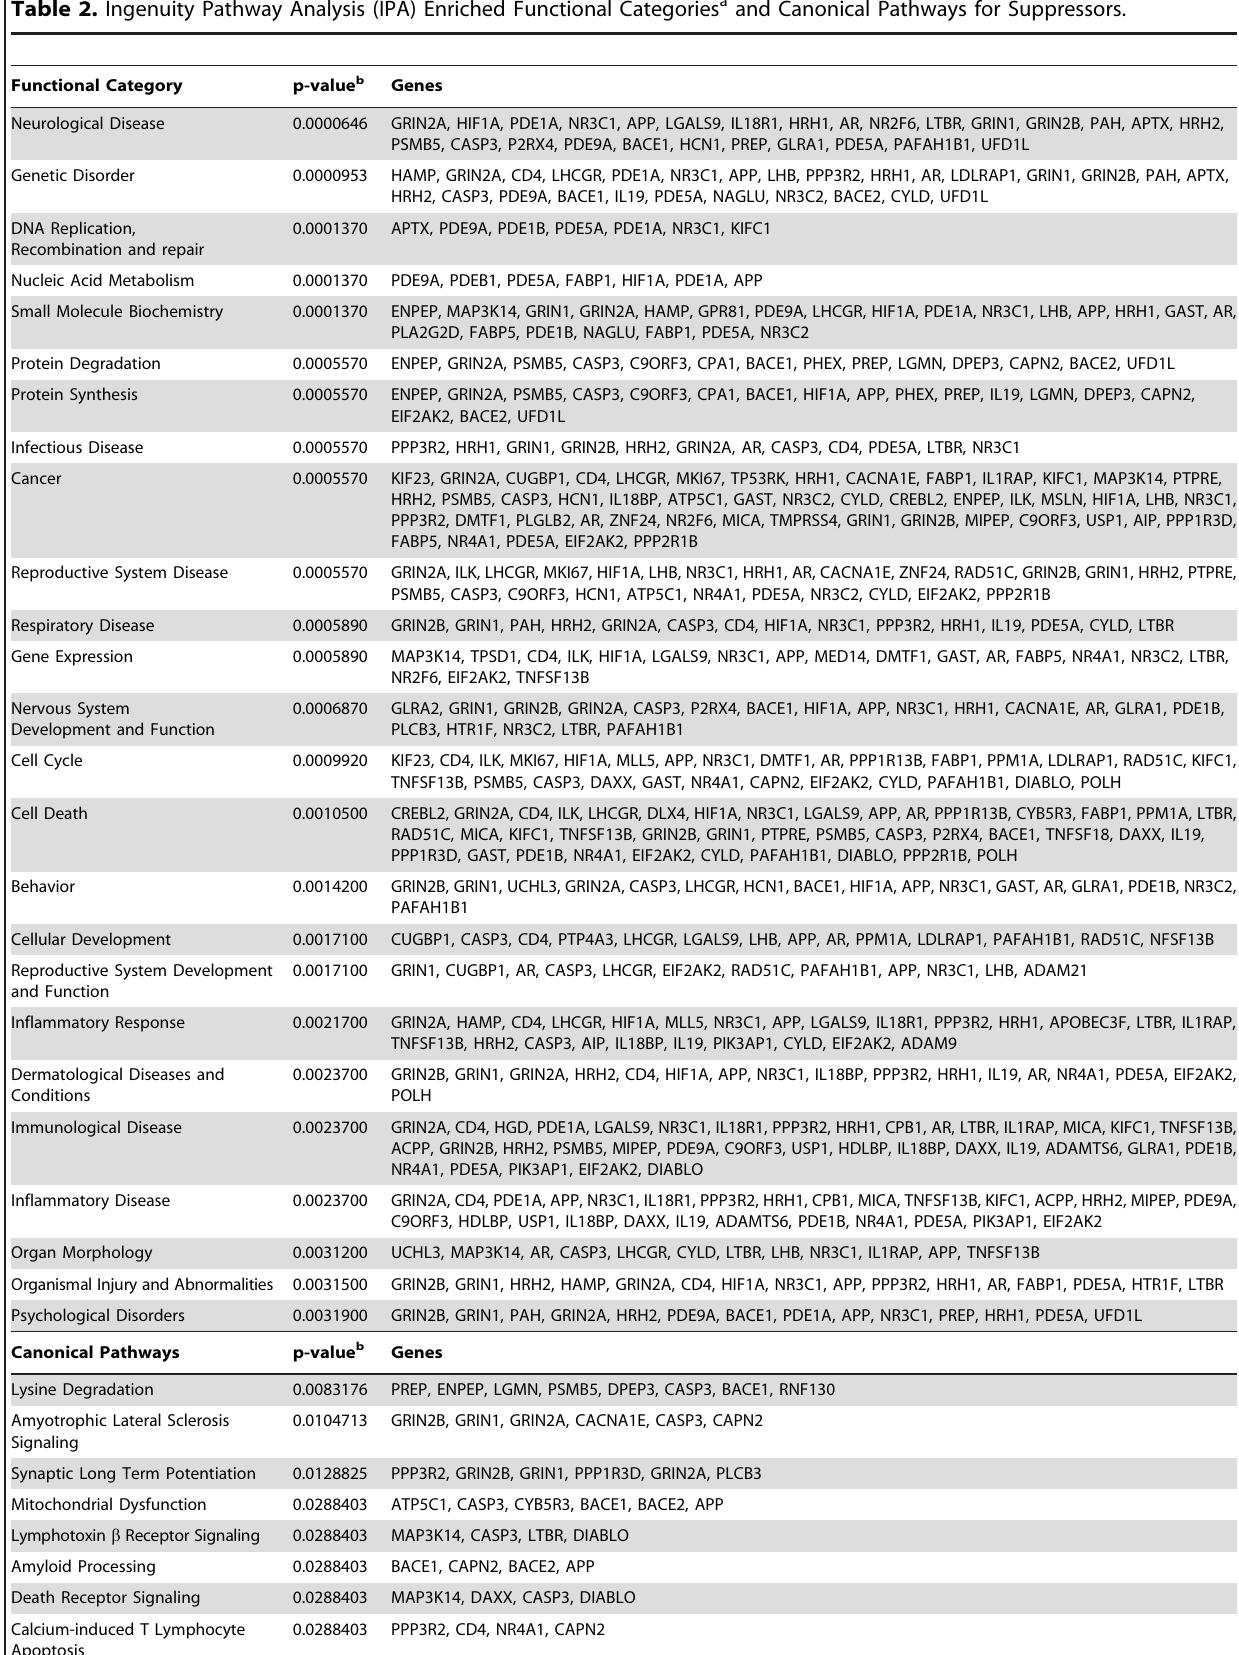
Table 2. Ingenuity Pathway Analysis (IPA) Enriched Functional Categories a and Canonical Pathways for